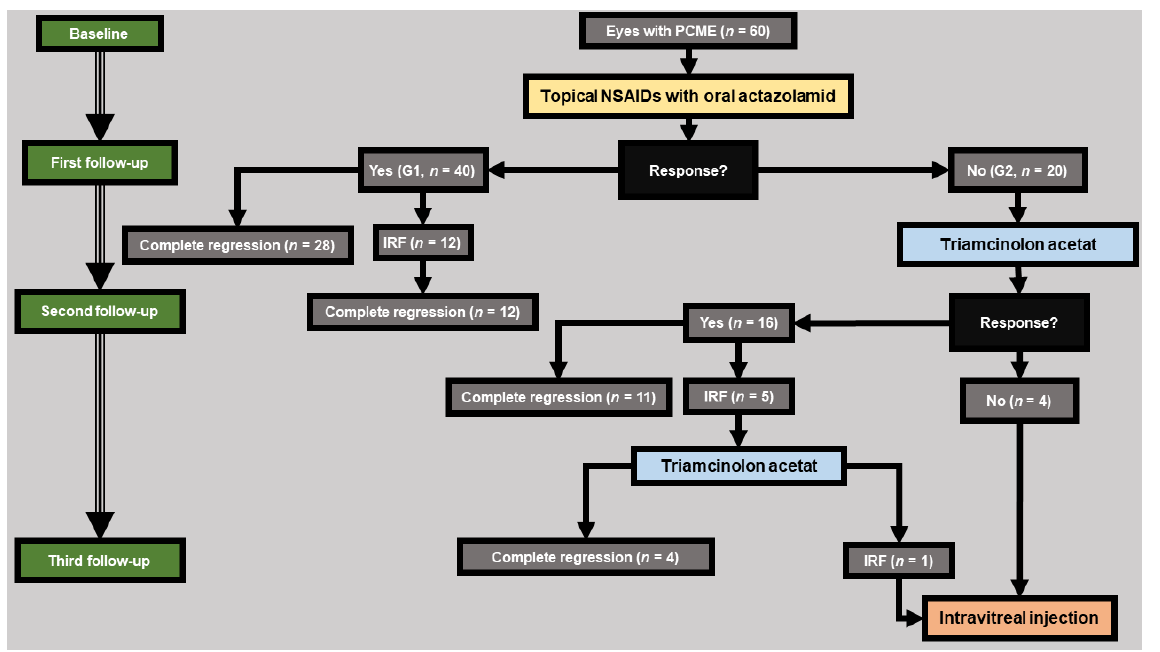
Figure 1. A detailed description of our treatment protocol, as well as the patient distribution in the two groups: Group 1 (response group G1, n = 40) : eyes that showed a therapeutic response under first-line therapy (NSAIDs eye drops in combination with acetazolamide) at first follow-up. Group 2 (non-response group G2, n = 20) : eyes that did not show a therapeutic response under first-line therapy and required additional therapy with subtenon triamcinolone acetate. Therapeutic response was defined by a reduction in CMT with an improvement in BCVA. PCME : Postoperative cystoid macular edema. NSAID : nonsteroidal anti-inflammatory eye drops. IRF : intraretinal fluid.